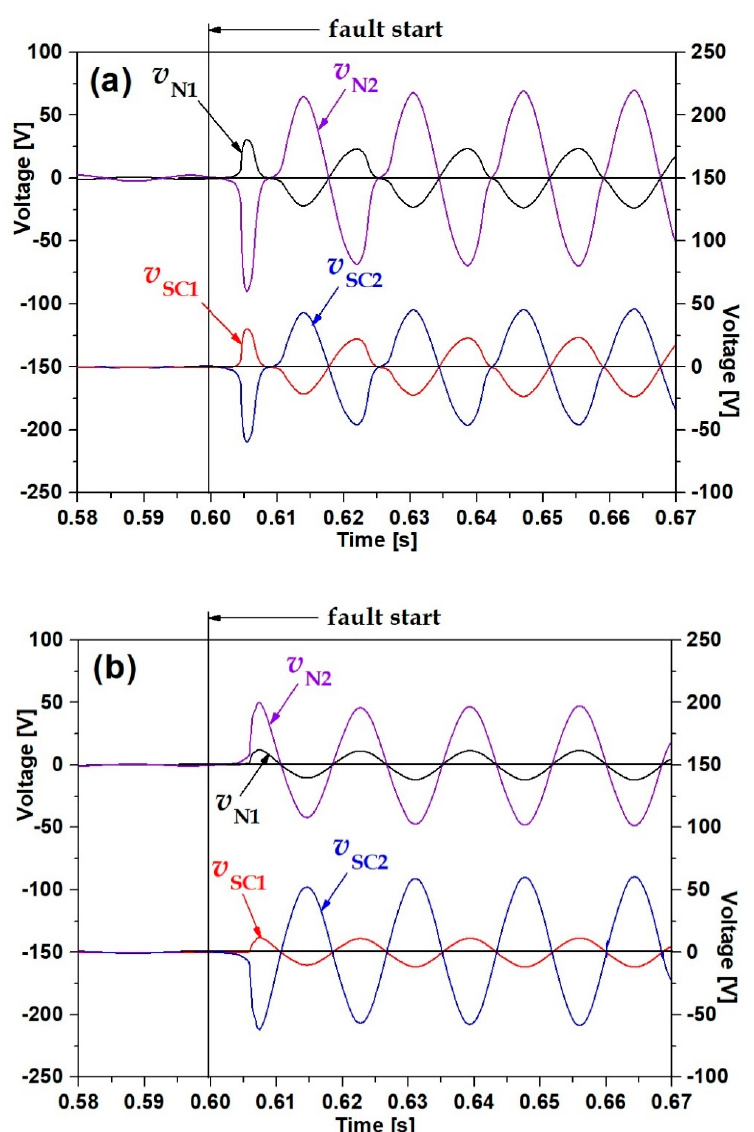
Figure 4. Voltage characteristics of two coupled windings and two superconducting elements according to the winding direction: ( a ) the reverse winding direction ( b ) the same winding direction.